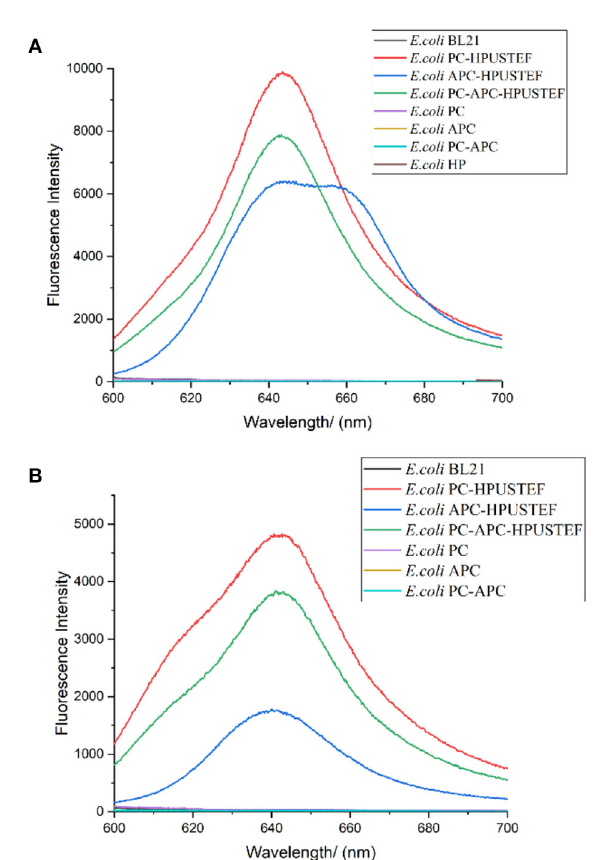
FIGURE5 Fluorescence emission spectrum of recombinant strain (Excitation wavelength is 580nm). (A) Unpurified protein samples of recombinant strain; (B) his-tag purified protein samples of recombinant